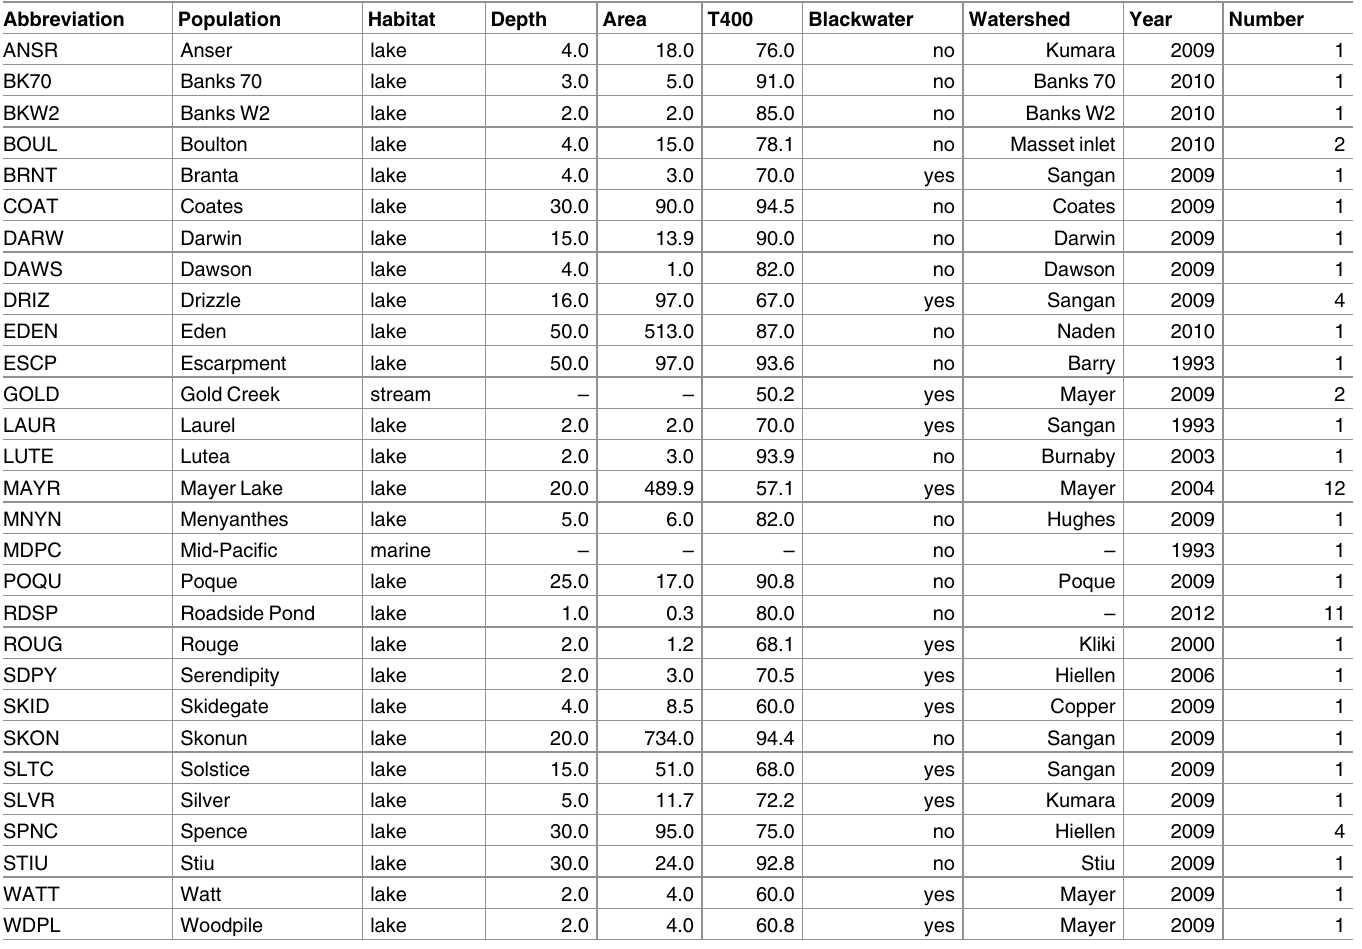
Table 1. Population